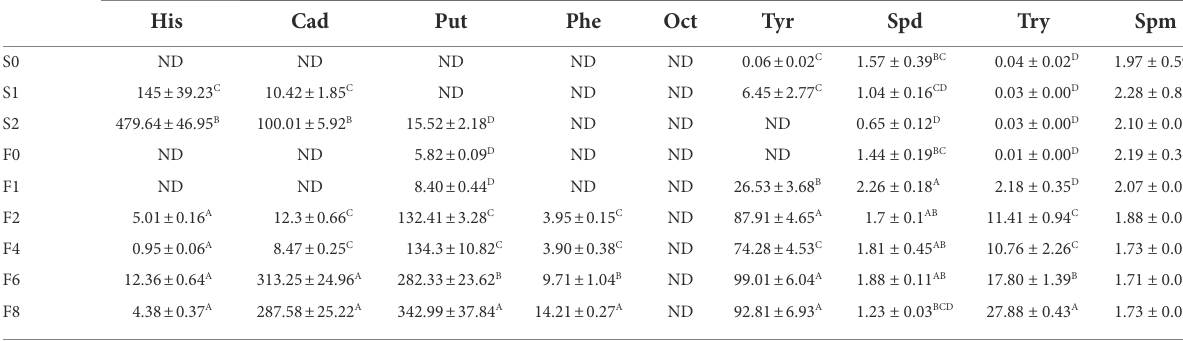
TABLE 1 Changes in the content of BAs. Sample